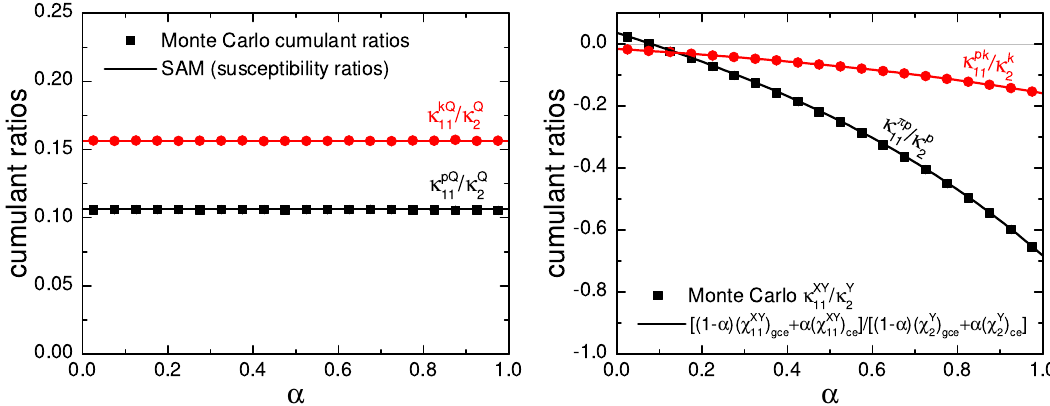
=(cid:20) Q and (cid:20) kQ =(cid:20) Q ( left panel ) and (cid:20) (cid:25)p 11 2 11 2